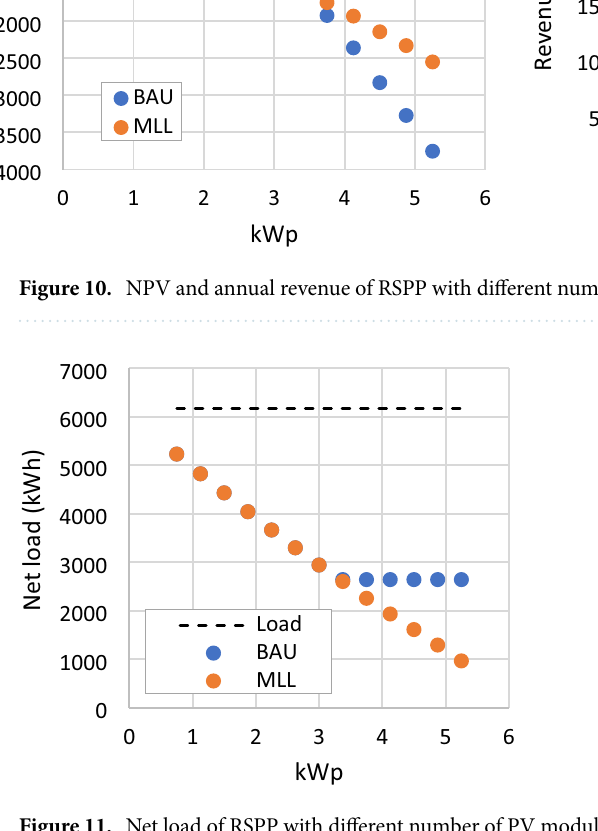
Figure 11. Net load of RSPP with different number of PV modules in MLL scenario.